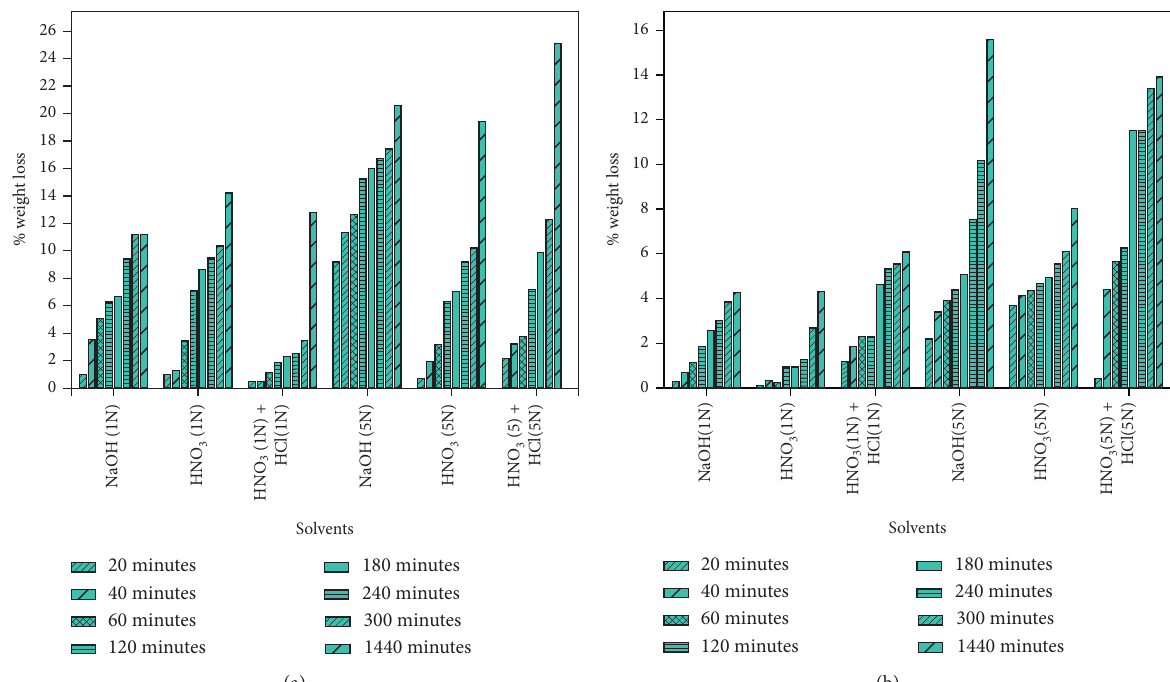
Figure 6: Chemical resistivity of (a) pinus-raw and (b)